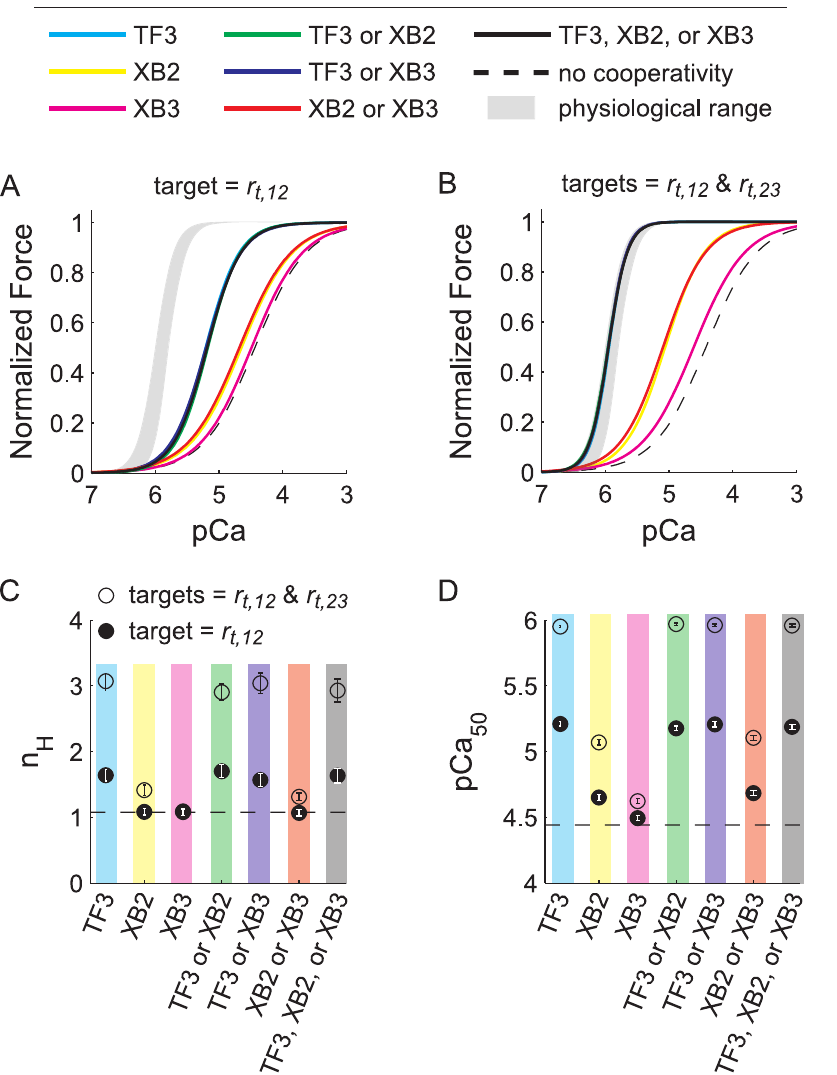
Figure 3. Multiple forms of cooperativity combine to simulate the physiological force-pCa relationship. Various combinations of cooperative thin filament activation kinetics affect the steady-state force-pCa response differently, shown for all possible source combinations when r t,12 was targeted (A) versus both r t,12 and r t,23 being targeted in combination (B). Each line depicts the 3-parameter Hill fit to the simulated force-pCa response, while symbols show n H (C) and pCa 50 (D) values for these fits, with error bars representing 95% confidence intervals. All simulations used standard parameter values: r Tn =1, k xb =3 pN nm 2 1 , k fil = k m = k a =1X, and a RU span of 9 actins. The dashed lines illustrate an example simulation in the absence of cooperative thin filament activation kinetics, which compares well with prior studies [25,27,43] after adjusting for K 9 1 (Table 3). The shaded underlay in panels A and B represents the measured physiological range from Figure 2.